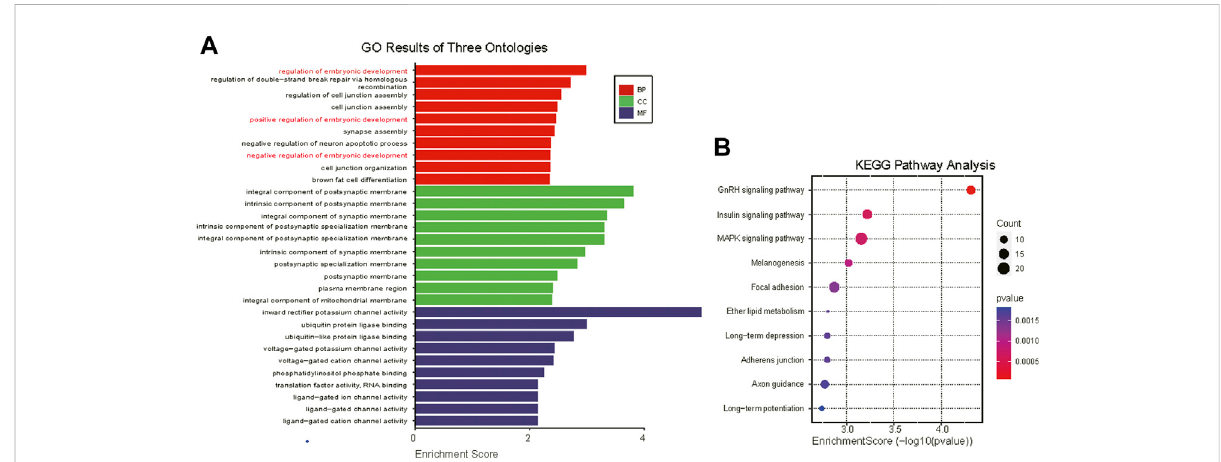
Gene Ontology (GO) and Kyoto Encyclopedia of Genes and Genomes (KEGG) pathway enrichment analyses of co-highly expressed tRNA- derived small (tsRNAs). (A) GO analysis of highly expressed tsRNAs target genes (only the top ten most signi fi cantly enriched signaling pathways undereachitemarepresented)BiologicalProcess,BP;Cellular Component, CC;Molecular Function,MF. (B) BubbleplotofKEGGanalysisoftsRNAs target genes.